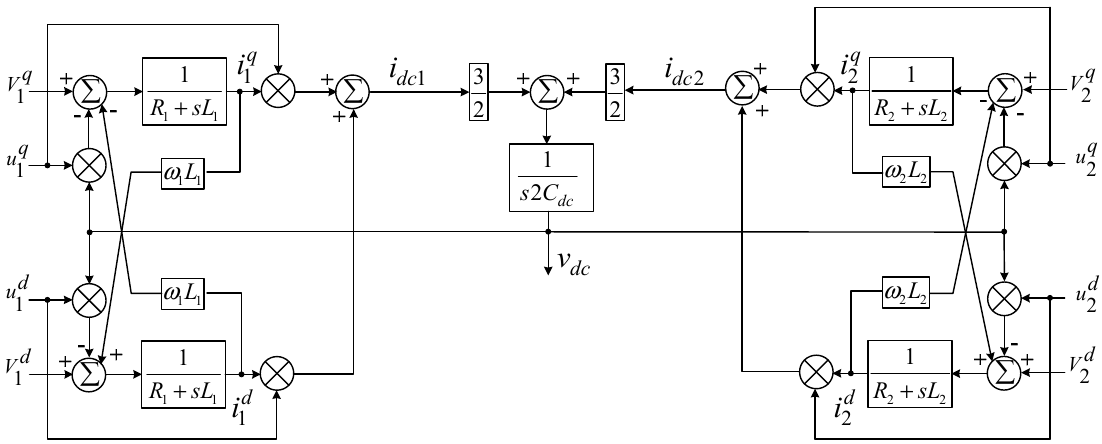
Figure 2. Block diagram representation for the three-phase back-to-back voltage source converter (BTB-VSC).